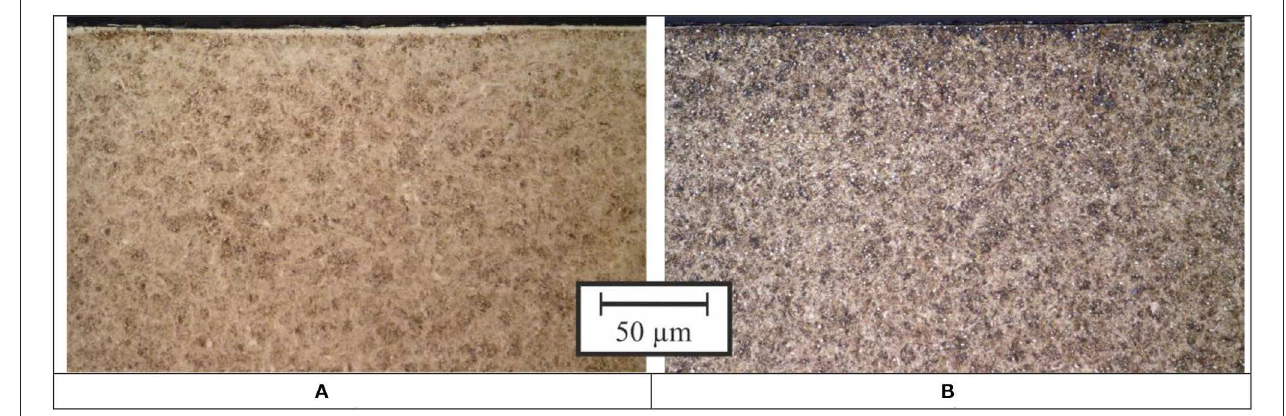
FIGURE 7 | Cross section of turn-rolled inner ring, (A) before test, (B) after 125 · 10 6